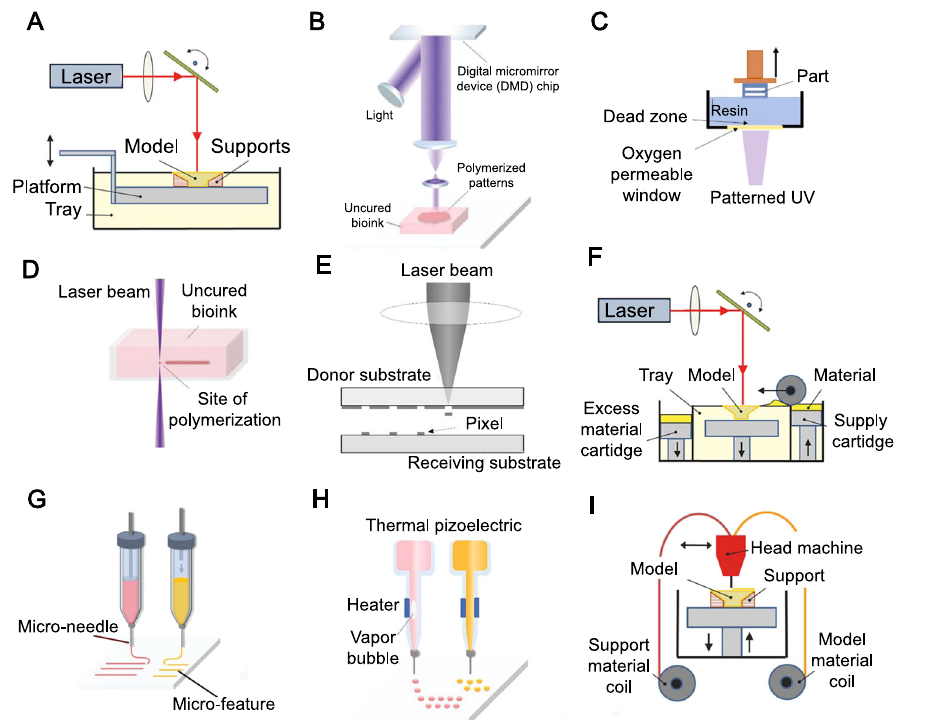
Fig. 2 | Schematics of the 3D printing technologies used for fabrication of microrobots. A Stereolithography (SLA). B Digital light processing (DLP). C Continuous liquid interface production (CLIP). D Direct laser writing (DLW) or two- or multi-photon polymerization (TPP or MPP). E Laser-induced